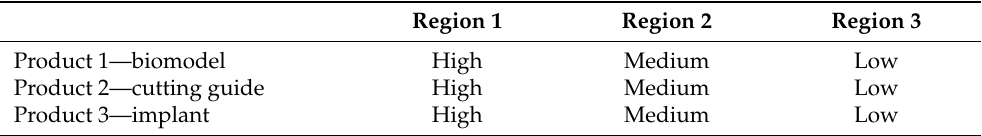
Table 8. Scenario 2 conditions.